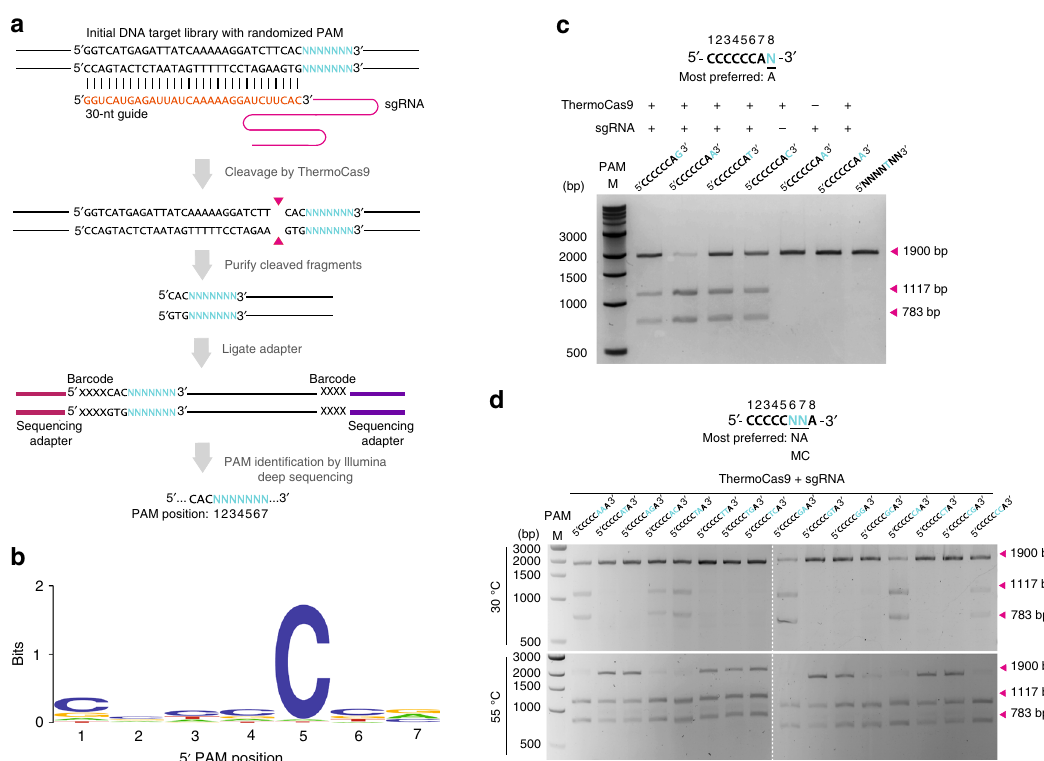
Fig. 2 ThermoCas9 PAM analysis. a Schematic illustrating the in vitro cleavage assay for discovering the position and identity (5 ′ -NNNNNNN-3 ′ ) of the protospacer adjacent motif (PAM). Magenta triangles indicate the cleavage position. b Sequence logo of the consensus 7 nt long PAM of ThermoCas9, obtained by comparative analysis of the ThermoCas9-based cleavage of target libraries. Letter height at each position is measured by information content. c Extension of the PAM identity to the eighth position by in vitro cleavage assay. Four linearized plasmid targets, each containing a distinct 5 ′ -CCCCCCAN- 3 ′ PAM, were incubated with ThermoCas9 and sgRNA at 55 °C for 1 h, then analyzed by agarose gel electrophoresis. Supplementary Fig. 8 shows the uncropped gel image. d In vitro cleavage assays for DNA targets with different PAMs at 30 and 55 °C. Sixteen linearized plasmid targets, each containing one distinct 5 ′ -CCCCCNNA-3 ′ PAM, were incubated with ThermoCas9 and sgRNA, then analyzed for cleavage ef fi ciency by agarose gel